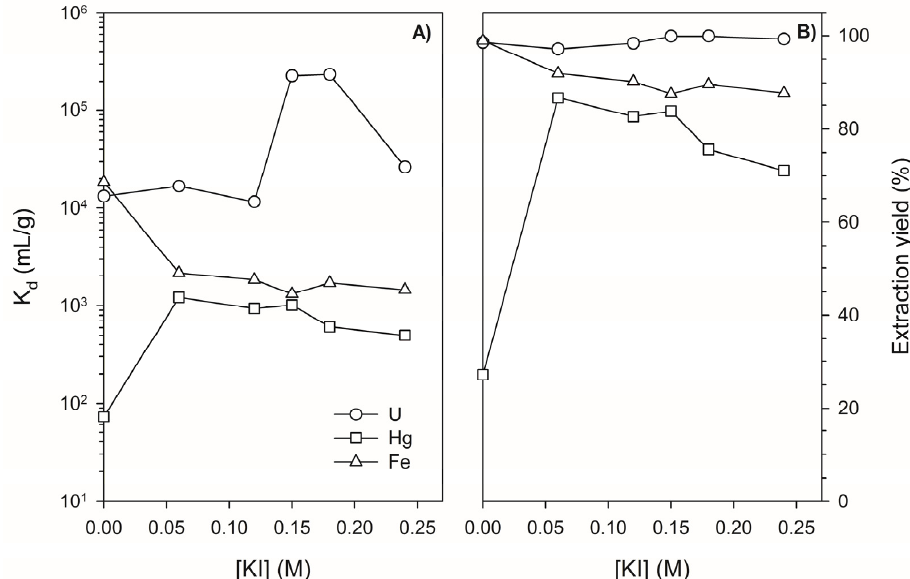
Figure 2. Impact of the KI concentration on the distribution coefficient values ( A ) and extraction yield ( B ) for U, Hg, and Fe on Lewatit TP260 at pH 1.8 (H 2 SO 4 media) (equilibration time, 24 h).